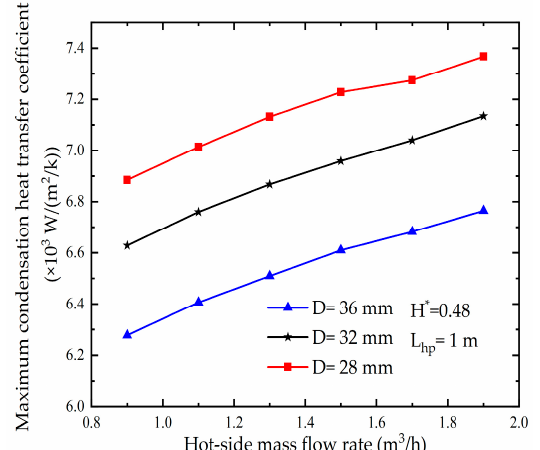
Figure 12. Comparison of maximum condensation heat transfer coefficient with different HP diameters. (The mass flow rate at cold side of the HPHEX is 2.9 m 3 /h.) * H